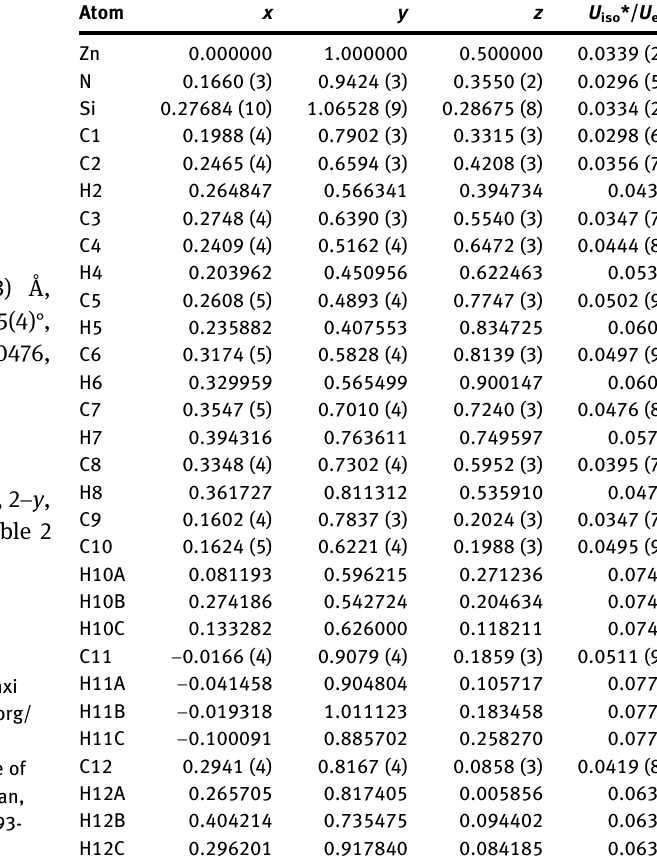
Table  : Fractional atomic coordinates and isotropic or equivalent isotropic displacement parameters (Å 